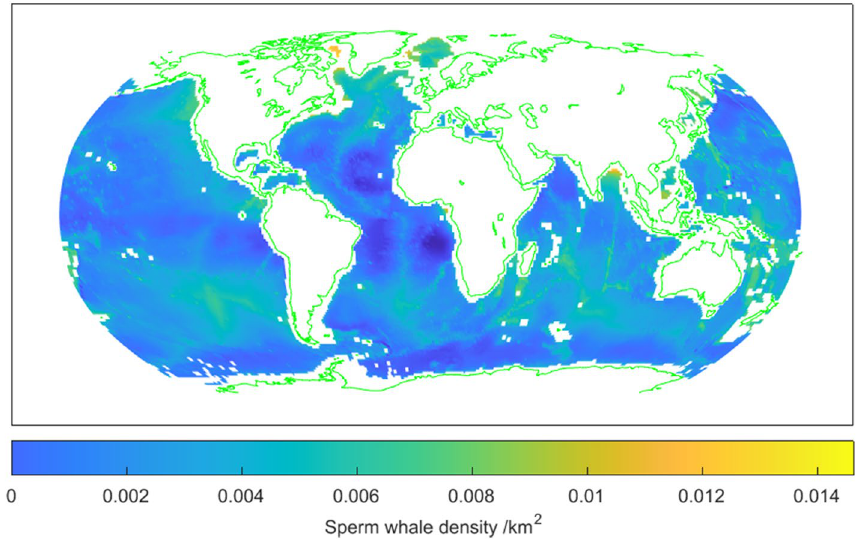
Figure 2. Predicted density of sperm whales from weighted stepwise regression of survey densities on oceanographic variables. Waters less than 1000 m deep and land are uncoloured. Map created using MATLAB2021b